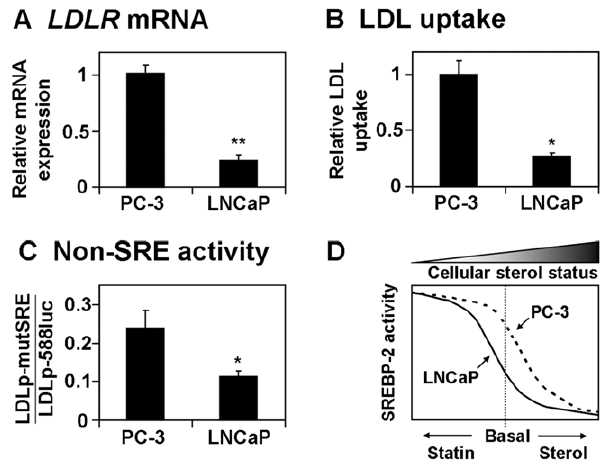
Figure 5. Basal LDLR gene expression and activity is higher in PC-3 than LNCaP cells. Data was pooled from experiments where LNCaP and PC-3 cells received vehicle treatment in Medium C for 24 h. (A) For each qRT-PCR experiment, the D C t values (for threshold=10 2 1.5 normalized fluorescence units) for the LDLR gene, relative to the PBGD housekeeping gene, were considered. Expression is represented as a fold change (relative to PC-3 cells), whereby a one-unit increase in D C t results in a two-fold decrease in mRNA expression. Data are presented as mean + SEM, from at least 4 separate experiments for each cell-line. (B) Raw LDL uptake, measured as fluorescence normalised by protein content in the LDL uptake assay, was averaged between experiments and made relative to the PC-3 cells. Data are presented as mean + SEM, from at least 3 separate experiments for each cell-line. (C) For each SRE- specific luciferase assay, the firefly/ Renilla luciferase ratios generated from the LDLp-mutSRE plasmid were normalised to that of the LDLp- 588luc plasmid. Data presented as mean + SEM, from at least 5 separate experiments for each cell-line. Each experiment in (A)–(C) was performed with triplicate wells per condition. * p , 0.05, ** p , 0.01, two-sample t -test versus PC-3 cells. (D) A model depicting the differences in cholesterol homeostasis between PC-3 and LNCaP cells. The threshold level of cellular cholesterol, at which SREBP-2 activity becomes dramatically reduced, may be higher in PC-3 cells. This would reduce the effect of statins, relative to the basal condition.